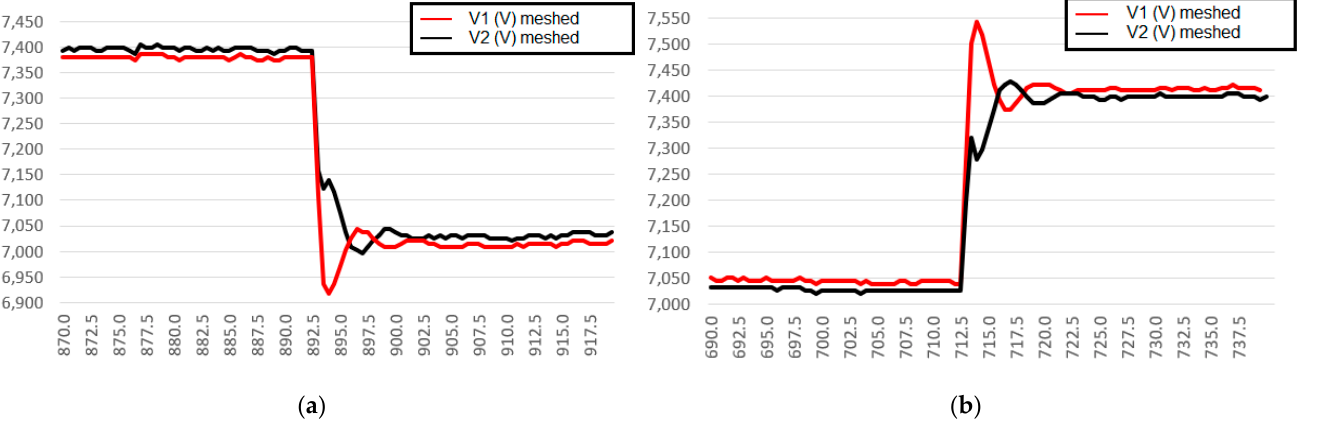
Figure 17. Terminal voltage dynamics with the series VSC; ( a ) R 1 insertion; ( b ) R 1 removal.